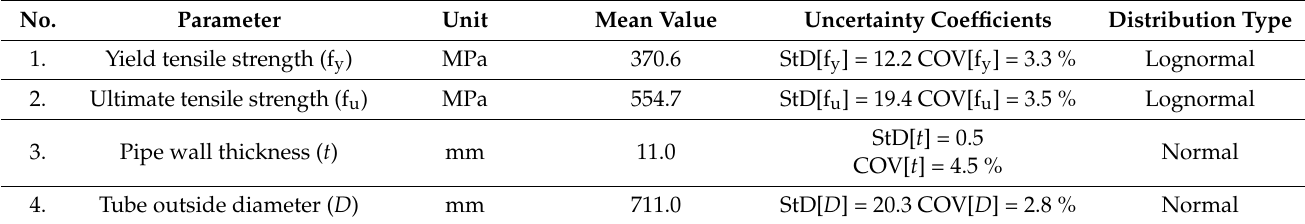
Table 5. Statistical distribution of input parameters for reliability evaluation. Source: Author’s analysis.